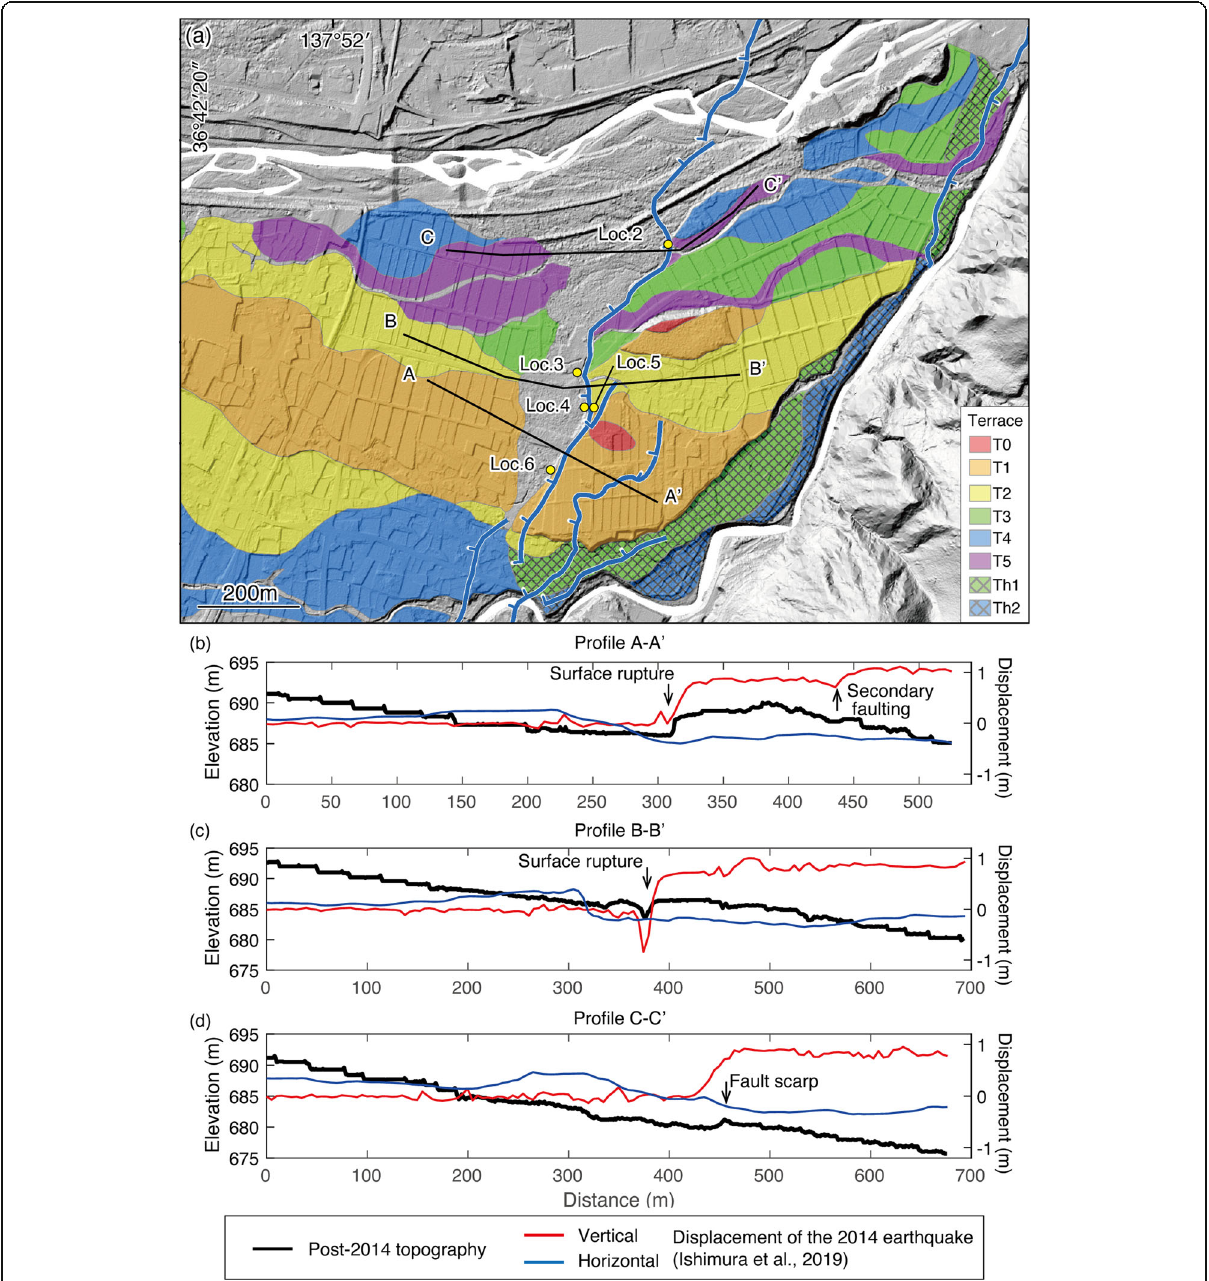
Fig. 6 a The interpreted distribution of terraces. b – d Pre-2014 event topography and vertical and horizontal displacements associated with the 2014 earthquake. b Profile A – A ′ . c Profile B – B ′ . d Profile C – C ′ . The profile locations are shown in a . Horizontal displacement is a